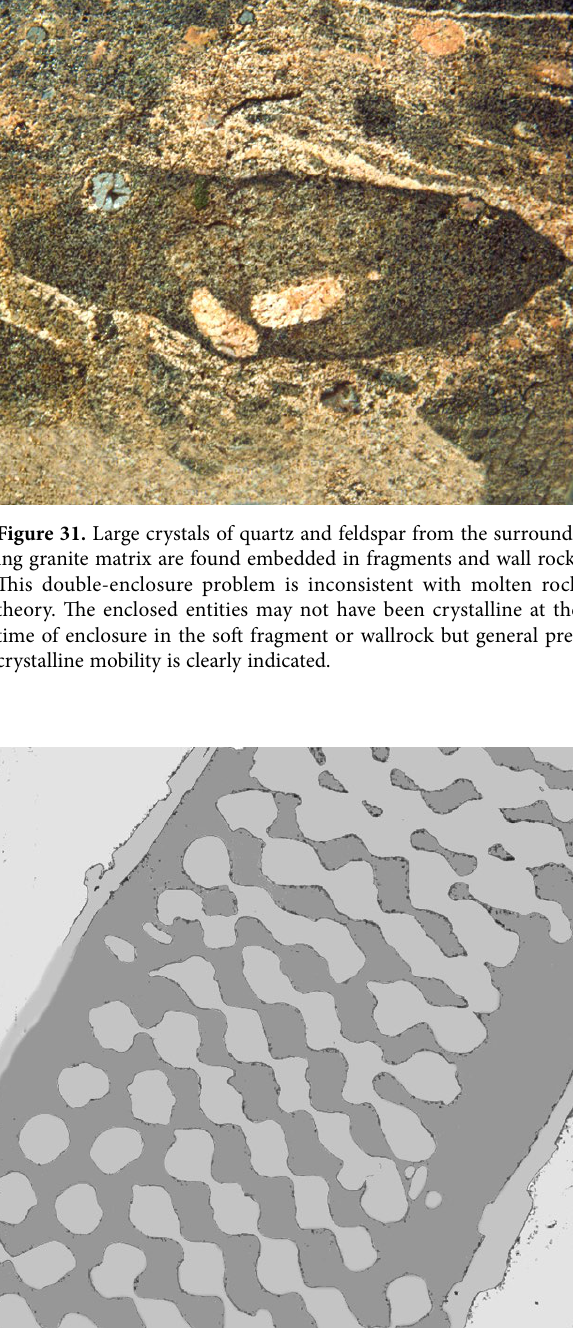
Figure 30. Granites containing orbicules (large concentric sphe- roids of feldspar and biotite) are simply incompatible with melt cooling. They clearly contradict Hutton’s classical molten rock the- ory. Petrological teaching avoids study or recognition of their exist- ence. Orbicular granites are regarded as a curiosity and the problem of how they are formed is simply not addressed.